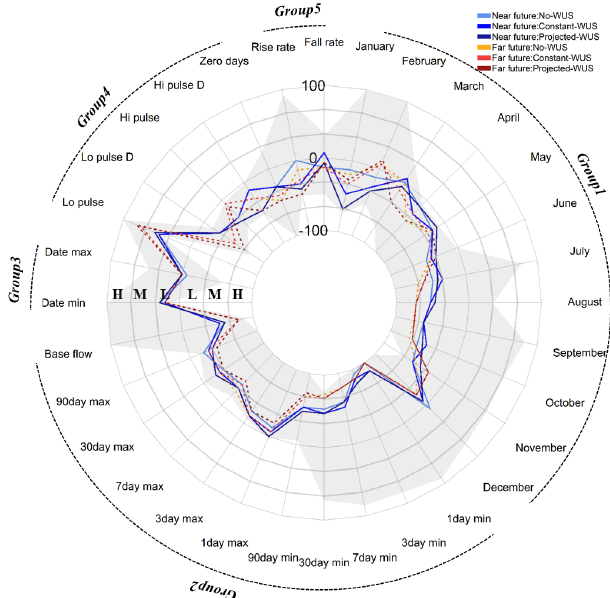
Figure 4. RVA (The Range of Variability Approach) deviation and classes of alteration (high (H), moderate (M), and low (L)) for IHA (Indicators of Hydrologic Alteration) in the near and far future un- der three different scenarios. No-WUS: the water use systems are not considered. Constant-WUS: the number of water use systems in the basin remain unaltered in the future. Projected-WUS: the num- ber of water use systems increases linearly with population growth. Alteration (uncertainty) band derived from minimum and maximum climate models for both near- and far-future simulations under three WUSs scenarios is shown in